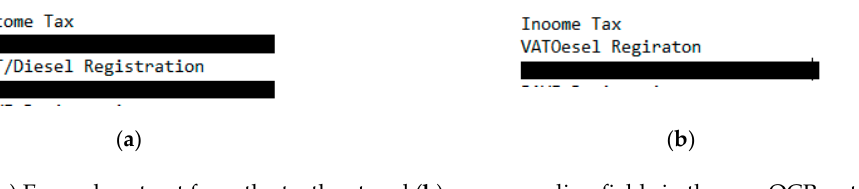
Figure 5. ( a ) Example extract from the truth set and ( b ) corresponding fields in the raw OCR output. This illustrates how the field names are misread by OCR in certain scenarios.